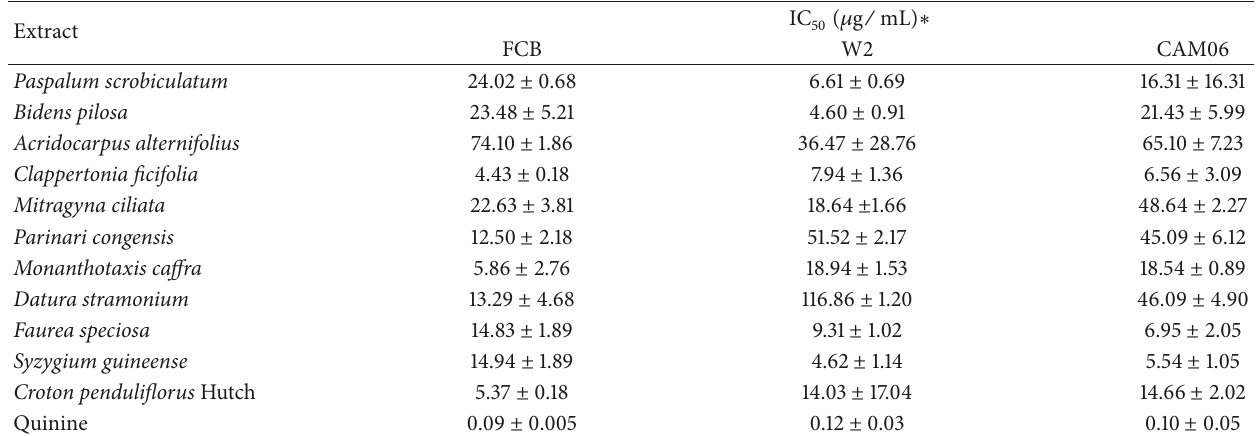
Table 3: In vitro antiplasmodial activity of plant